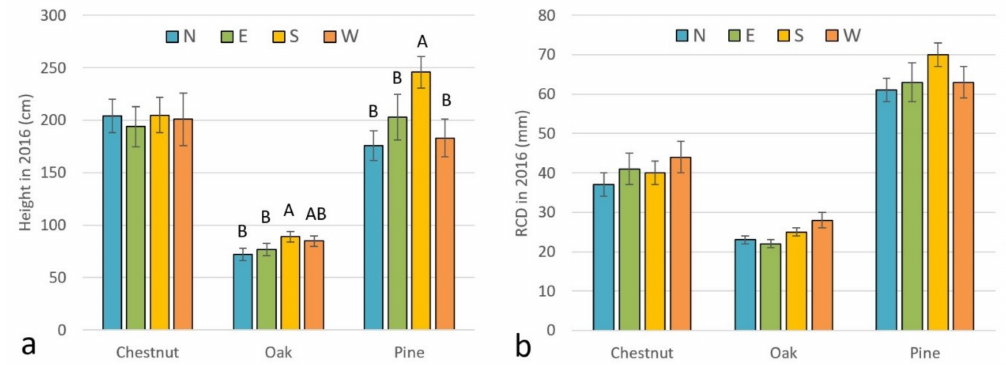
Figure 5. Mean ( a ) height and ( b ) root collar diameter of seedlings planted on ungraded plots, on slopes facing each of the four cardinal directions. Di ff erent letters indicate significant di ff erences between aspects for that particular species. An absence of letters indicates that no significant di ff erence was